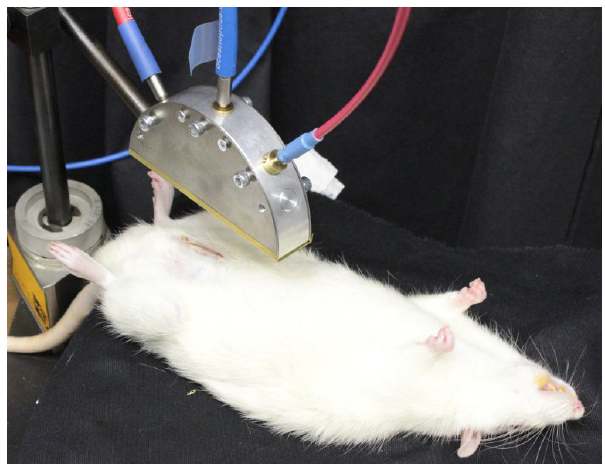
Fig. 1. The home-made holder with the three lightguides above the laboratory animal before placing on the measured tissue. The middle lightguide serves for excitation and the two other are used for collecting the °uorescence and NIR phos- phorescence